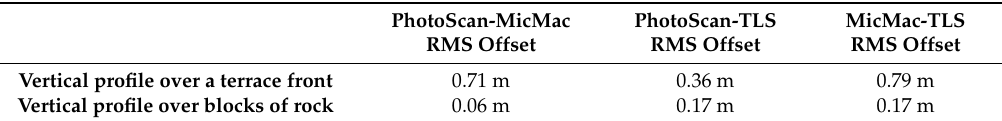
Table 4. Comparison of vertical profiles on particular features of metric size, calculating Root Mean Square (RMS) offset.